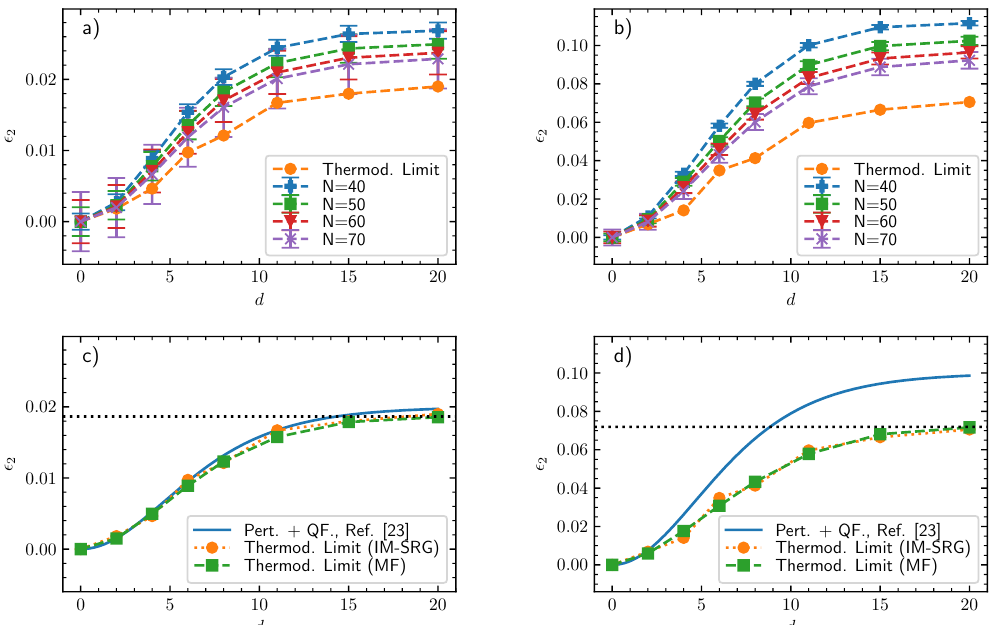
Figure 9: Interaction potential for two repulsive impurities induced by the Bose gas = 0.02 and panel b) shows c = 0.1. The curves for γ = 0.02: panel a) shows c 2 2 display different values of N listed in the insets. We also show our prediction for the induced interaction potential in the thermodynamic limit. No error bars are shown for this case, since we cannot estimate them reliably, see text. In the lower panels, we compare our prediction for the thermodynamic limit (orange squares) with the corresponding result based upon perturbation theory, which includes quantum fluc- tuations [ 23 ] (solid blue curve), and the mean-field result (green dots). Panels c) = 0.02 and c = 0.1, respectively. The dotted lines in c) and d) and d) are for c 2 2 ( c = 0, c ) − E ( c = 0, c = 0 ) in the show the self-energies of a single impurity, E 2 1 2 2 1 2 thermodynamic limit while the dashed curves are added to guide the